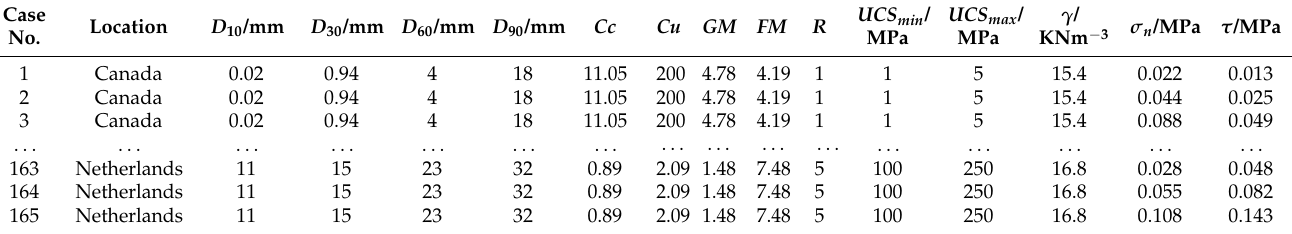
Table 1. Rockfill materials shear strength case history